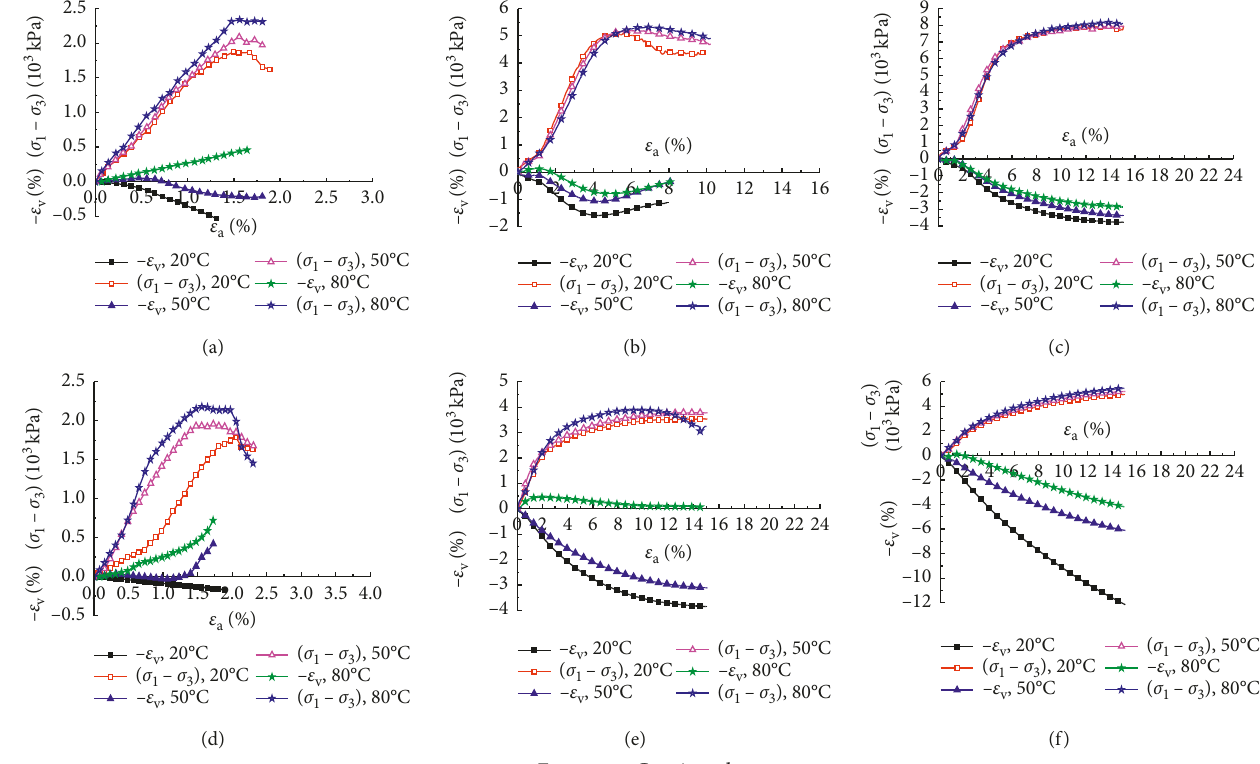
Figure 4: The relationship curves of ( σ confining pressures, and temperatures. (a) ρ w